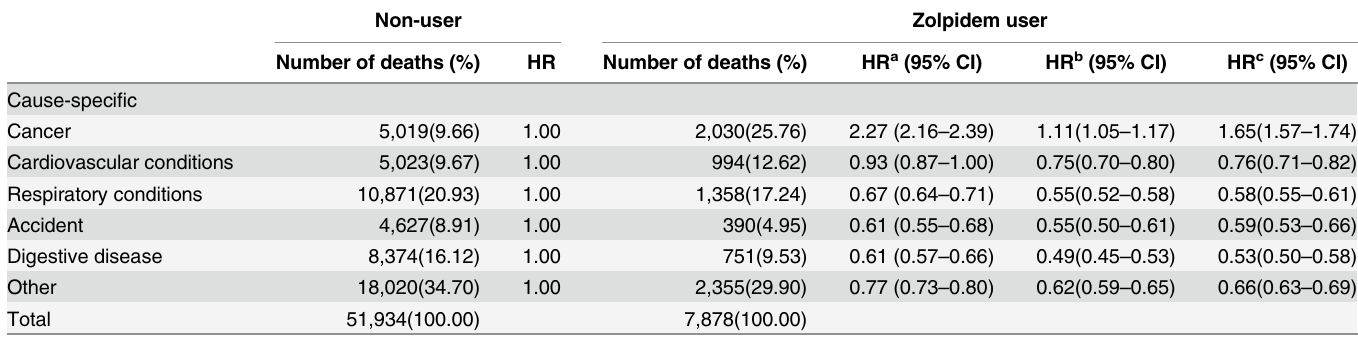
Table 5. Analysis of the causes of death of the study subjects who only used zolpidem.